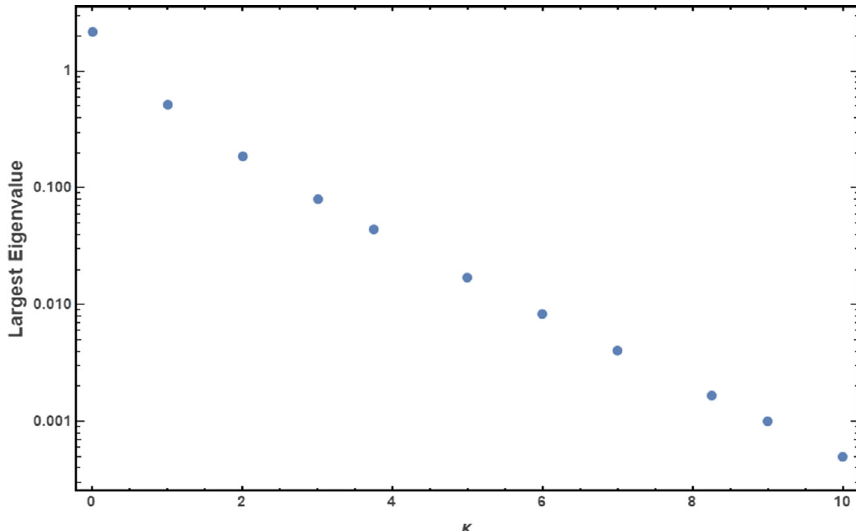
Fig. 13 Largest eigenvalue of the Hamiltonian for a matrix size of N = 13000 and several values of